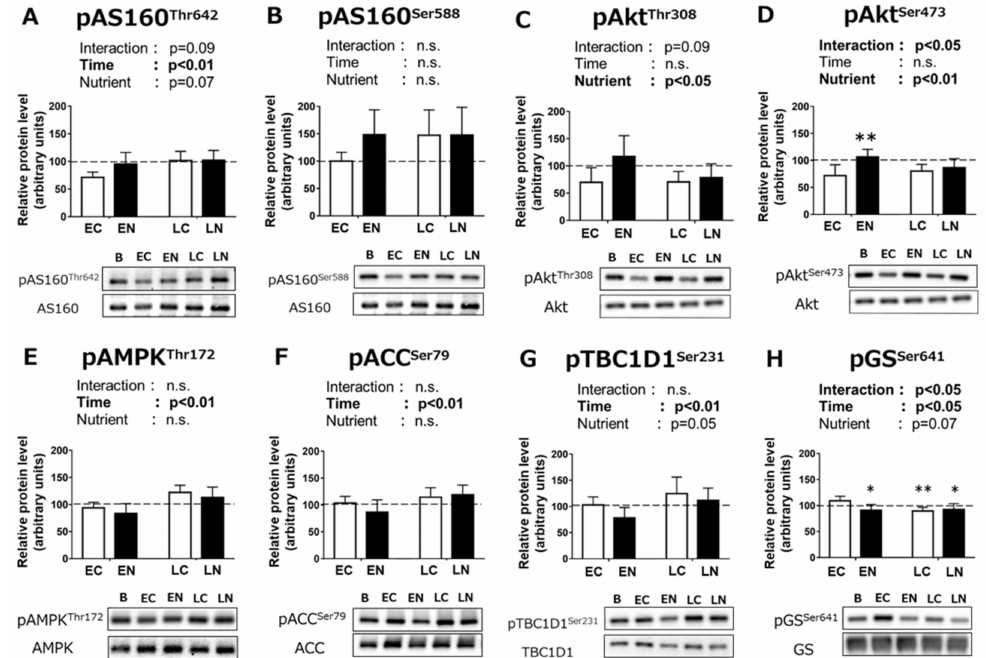
Figure 4. E ff ects of post-exercise nutrient intake on phosphorylation levels of proteins related to carbohydrate metabolism. ( A ) Akt substrate 160 kDa (AS160) Thr642 and ( B ) Ser588, ( C ) Akt Thr308 and ( D ) Ser473, ( E ) 5’-AMP-activated protein kinase (AMPK) Thr172, ( F ) acetyl-CoA carboxylase (ACC) Ser79, ( G ) TBC1 domain family member 1 (TBC1D1) Ser231, and ( H ) glycogen synthase (GS) Ser641 phosphorylation status in mouse plantaris muscle at 30 min after oral intake of nutrients or water. The experimental protocol was the same as that described in the Figure 3 legend. Dashed lines indicate the baseline values (B, sedentary control). All data shown are relative to the baseline values ± SE. n = 6 or 7 per group. * p < 0.05, ** p < 0.01 vs. the